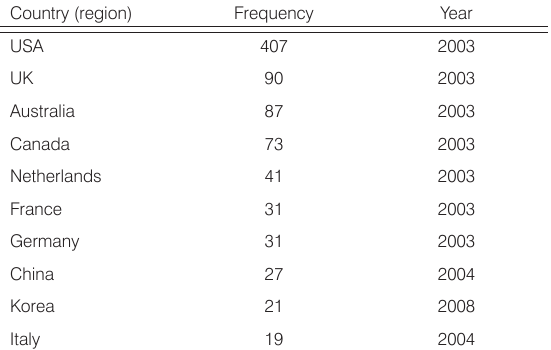
Table 1. The top 10 countries (regions) publishing research on self-management by patients with breast cancer.